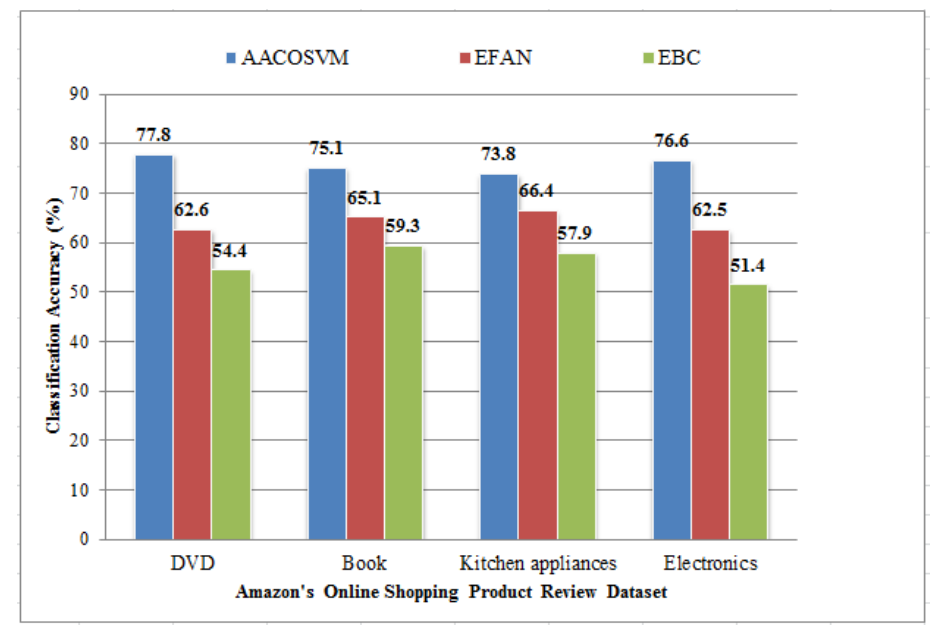
Figure 2. Classification Accuracy vs.